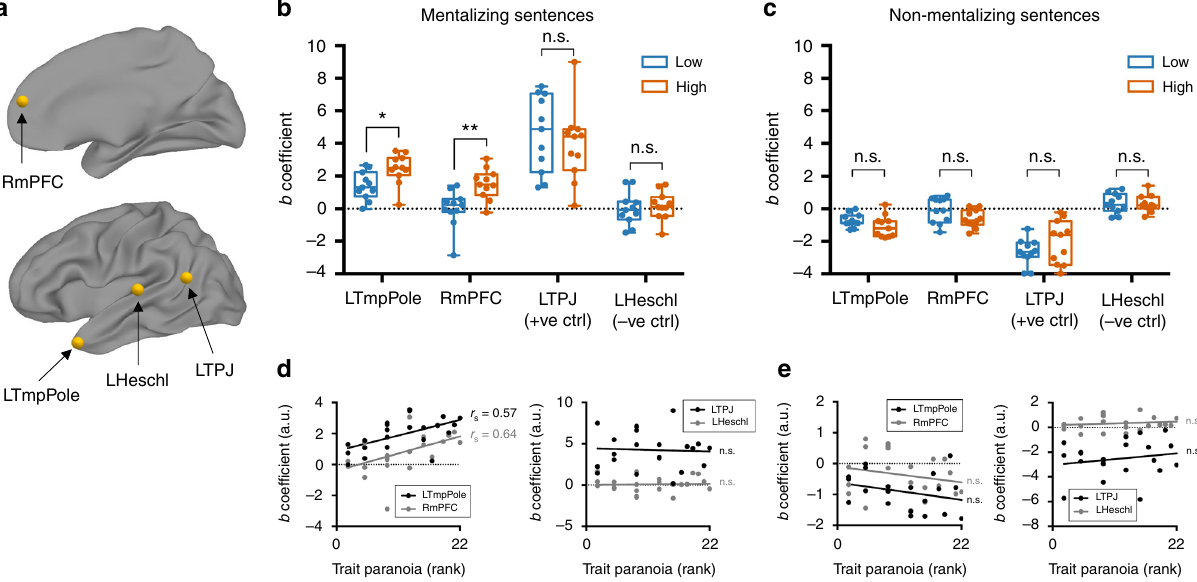
Fig. 5 Response to mentalizing events is stronger in high- compared to low-paranoia individuals. a Regions of interest (ROIs) for the event-related analysis. LTmpPole, left temporal pole; RmPFC, right medial prefrontal cortex; LTPJ, left temporo-parietal junction; LHeschl, left Heschl ’ s gyrus. b Comparison of beta coef fi cients for each ROI for the mentalizing-events regressor between the paranoia groups (low, blue; high, orange). Each dot represents a subject. Boxes represent the median and 25th/75th percentiles, and whiskers represent the minimum and maximum. * p = 0.01; ** p < 0.007; n.s., not signi fi cant ( p -values adjusted to control the false discovery rate at Q = 5%). c Comparison of beta coef fi cients for each ROI for the non-mentalizing-events regressor (the inverse of the mentalizing-events regressor shown in b ). Each dot represents a subject. Boxes represent the median and 25th/75th percentiles, and whiskers represent the minimum and maximum. d Post-hoc continuous analysis: Beta coef fi cients for the mentalizing-events regressor plotted against paranoia rank (coef fi cient values are the same as in b ). Left panel: the two ROIs in which beta coef fi cient was hypothesized to scale with trait paranoia (LTmpPole and RmPFC). Right panel: the two control ROIs (LTPJ and LHeschl). Correlations between paranoia rank and beta coef fi cient: LTmpPole, r s = 0.57, p = 0.005; RmPFC, r s = 0.64, p = 0.001; LTPJ, r s = − 0.04, p = 0.86, LHeschl, r s = 0.02, p = 0.95. e Beta coef fi cients for the non-mentalizing-events regressor plotted against paranoia rank (coef fi cients are the same as in c ). Left and right panels as in d . Correlations between paranoia rank and beta coef fi cients (all n.s.): LTmpPole, r s = − 0.28, p = 0.21; RmPFC, r s = − 0.22, p = 0.33; LTPJ, r s = 0.085, p = 0.71; LHeschl, r s = 0.17, p =